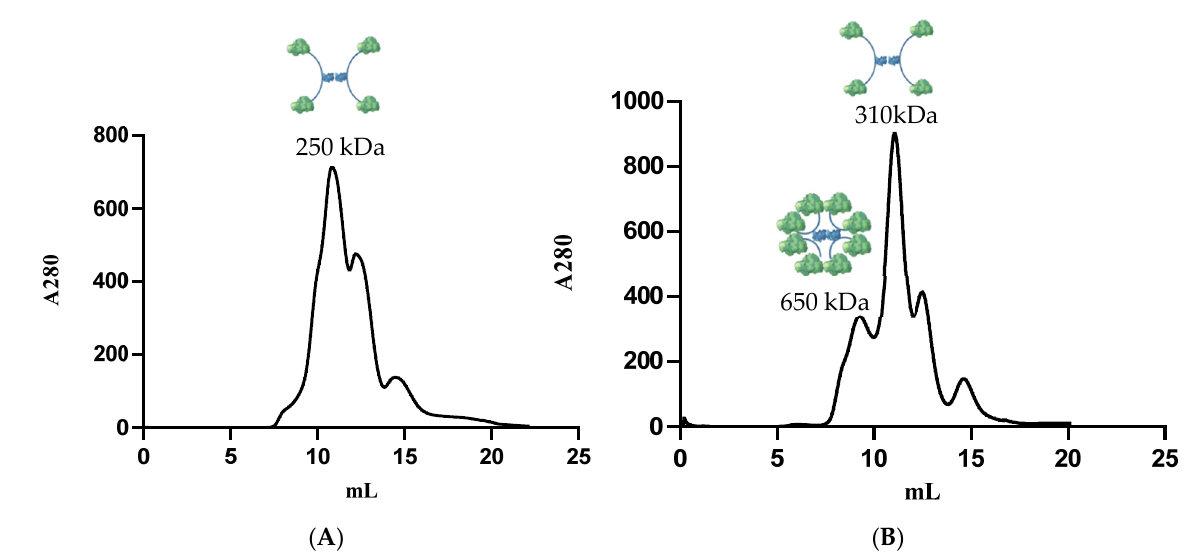
Figure 2. Gel filtration chromatograms of the enzyme mixtures. ( A ) mixture of PTDH A and PAMO I ; ( B ) mixture of PTDH A2 and PAMO I